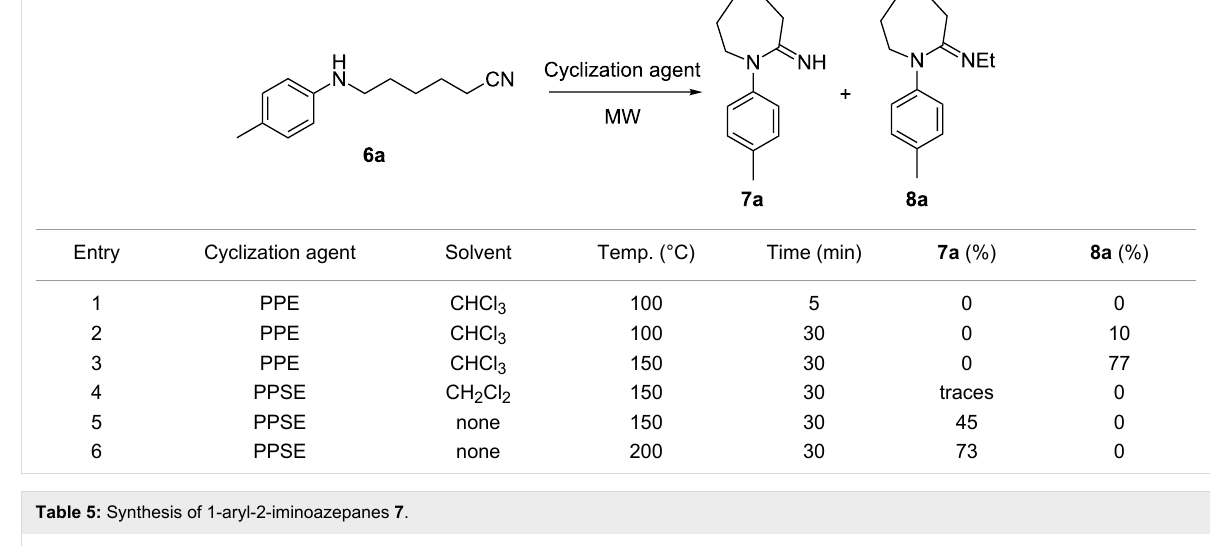
Table 4: Reaction conditions screening for 1-( p -tolyl)-2-iminoazepane ( 7a ).